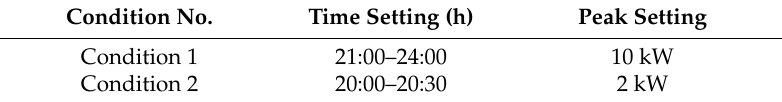
Figure 9. The result of applying net-zero energy operating conditions. Table 3. The peak control operating conditions (2).